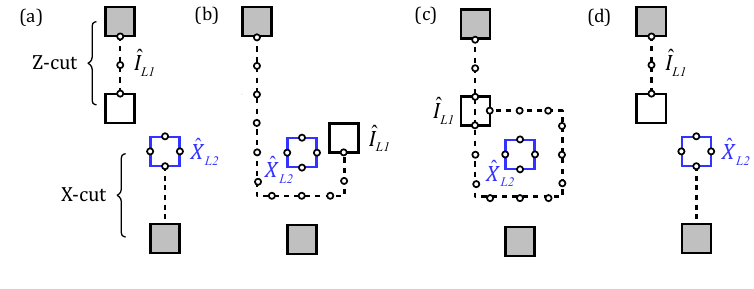
⊗ X . After the move, there is L 1 L 2